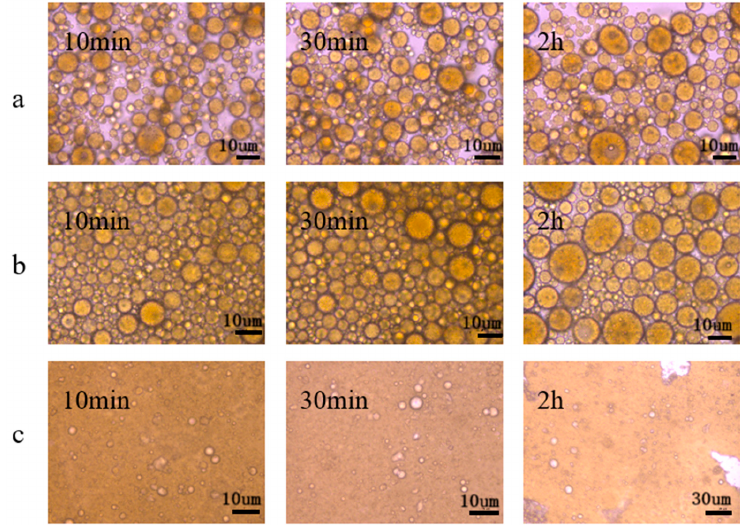
Figure 6. Microstructure of emulsions at different oil–water ratios. ( a ) 3:7, ( b ) 5:5, ( c ) 7:3.